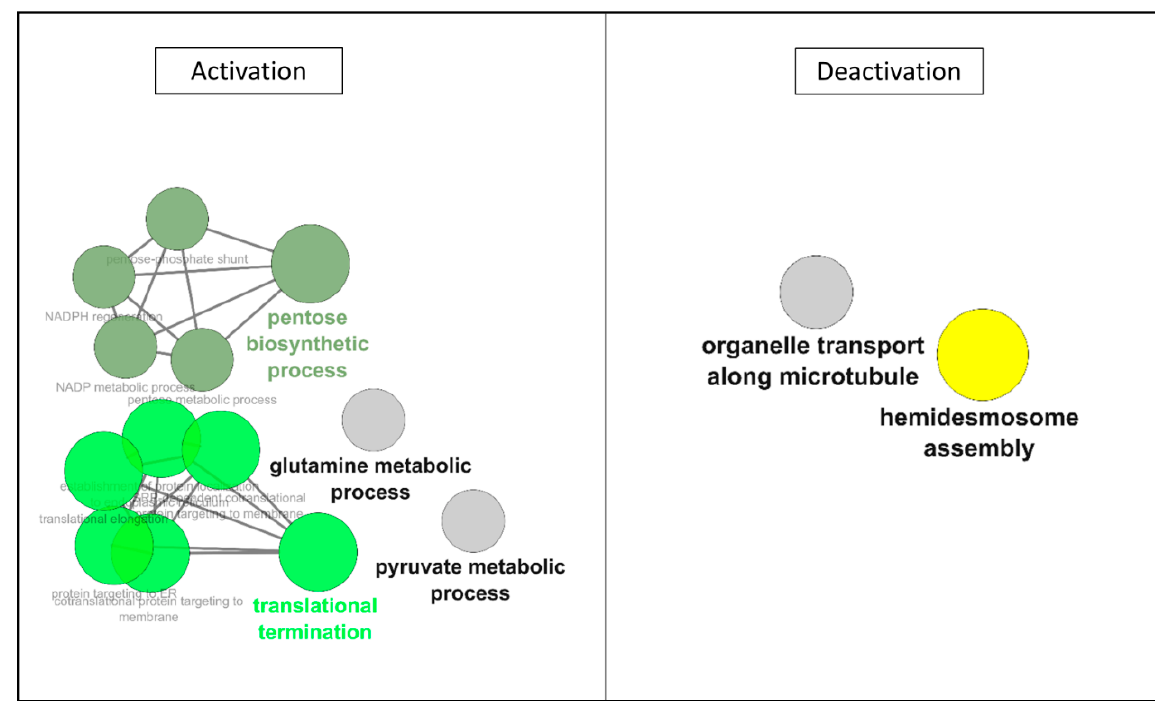
Figure 5. ClueGO Network Representation of Affected motifs between 3 and 6 h of hypothermic hypoxia. The list of protein motifs unaffected by the protocol were analyzed in Cytoscape’s ClueGO to identify their ontology and network associations. Results are illustrated as a functionally grouped network of terms/pathways. The most significant term of a group is considered to be the leading terms and is highlighted (bolded name). Disc size represents the number of motifs identified in the specified ontology (small: 3–6; medium: 7–9; large: 10 and more).